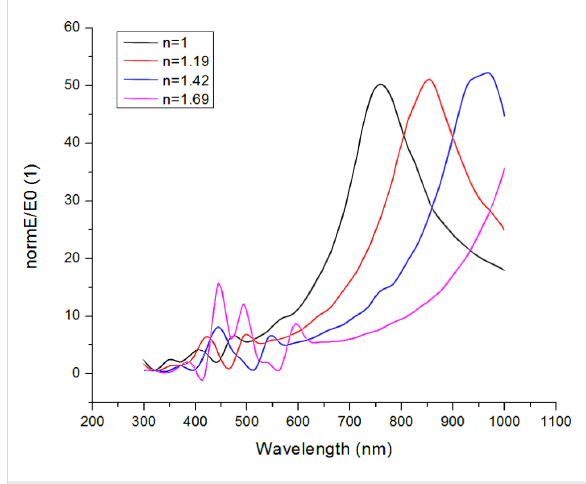
Figure 13: Dependence of the field enhancement in the centre of the gap of a bowtie antenna structure on the index of refraction ( n = ε 0.5 ) of the cover layer. The substrate is glass ( n =